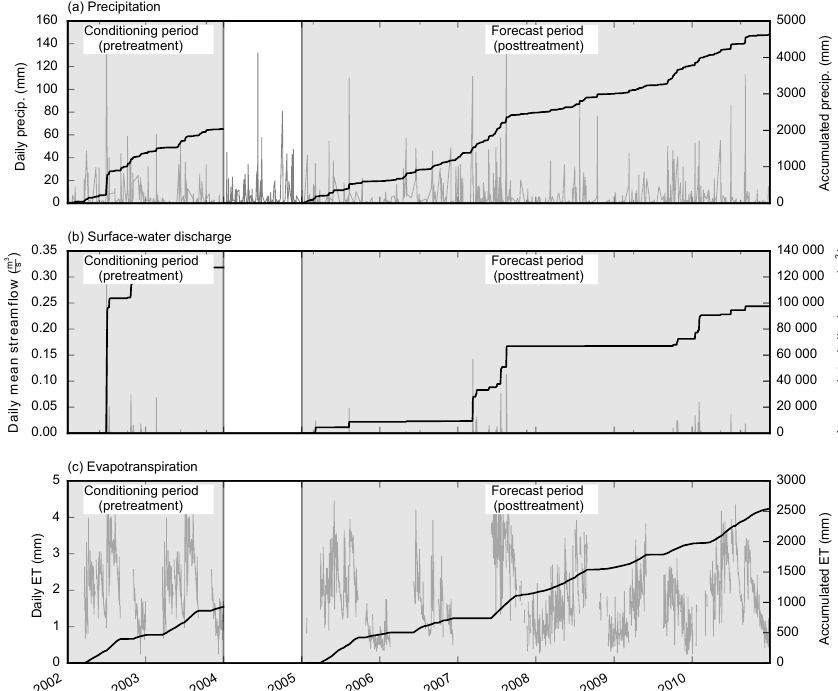
Figure 2. Summary of (a) precipitation, (b) streamflow, and (c) evapotranspiration used in the modeling analysis. Accumulated values for the conditioning and forecast period are shown in heavy black lines. Precipitation, streamflow, and evapotranspiration estimates are from Banta and Slattery